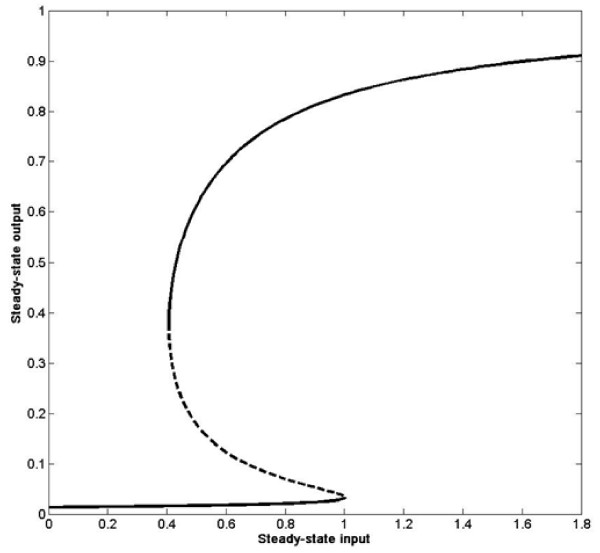
Steady state input-output curves.